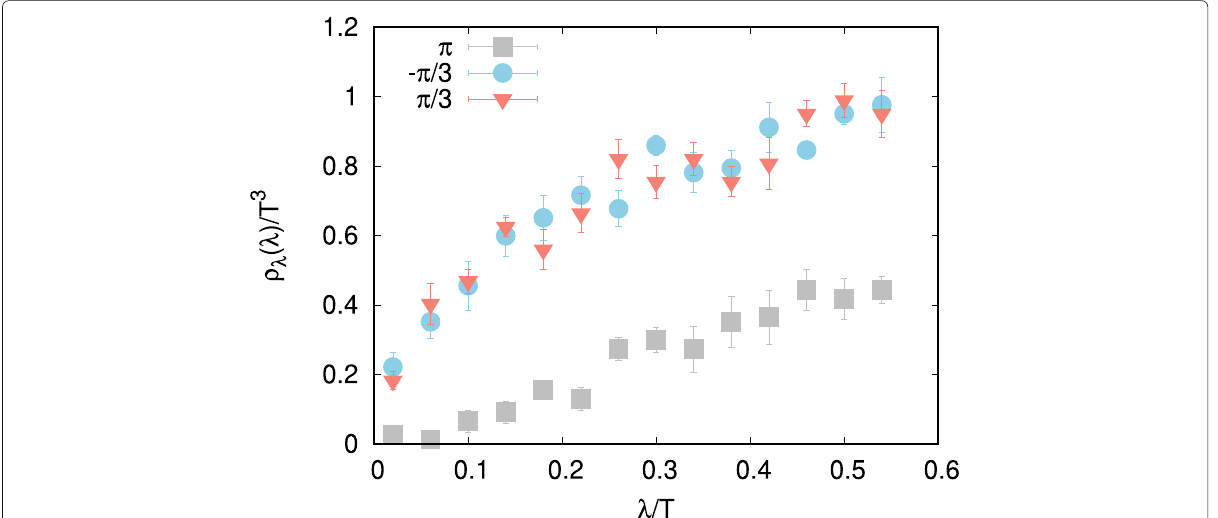
Fig. 2 The eigenvalue distribution of a valence Dirac operator (overlap operator) with temporal periodicity phases π , − π/ 3, π/ 3 respectively on 2+1 flavor QCD gauge ensembles. It is evident from the plot that whereas the chiral condensate in QCD due to the L-dyons (corresponding to the usual anti-periodic boundary condition given by φ = π ) vanishes at around 1.1 T c , the contributions from M-dyons survive. This figure has been taken from Ref.